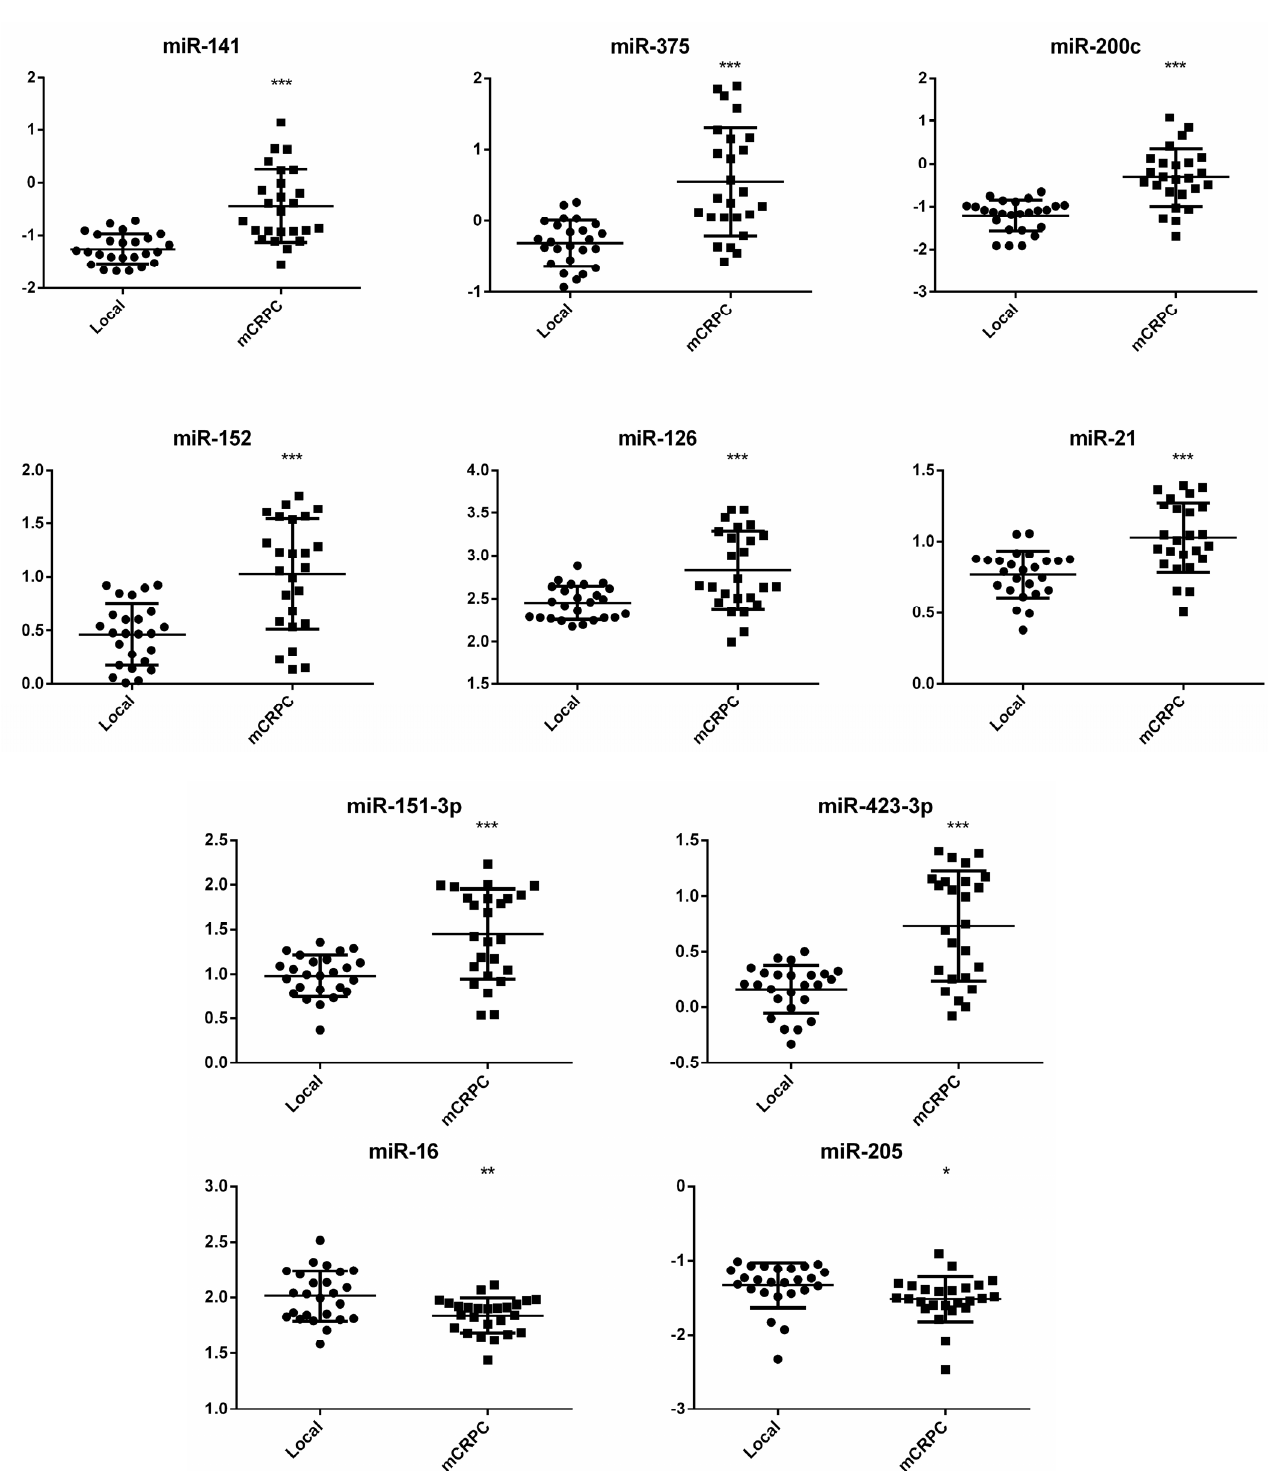
Figure 1. Quantitative RT-PCR analysis of upregulated and downregulated miRNAs in individual plasma samples from patients with localized (local) prostate cancer (PCa) or metastatic castration-resistant PCa (mCRPC). Quantification cycle (Cq) values were converted to log base amounts based on the cell line reference expression as outlined in the Materials section. Statistical analysis was carried out using the Student’s t -test. * indicates p < 0.05, ** indicates p < 0.01 and *** indicates p <